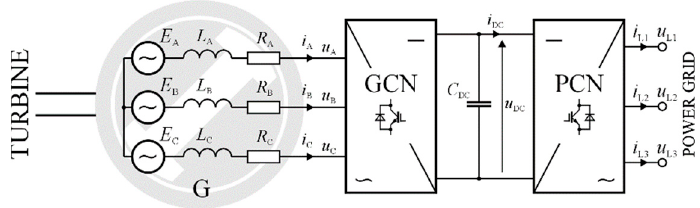
Figure 7. Diagram of the model of standard system (MSS) in the simulation studies.